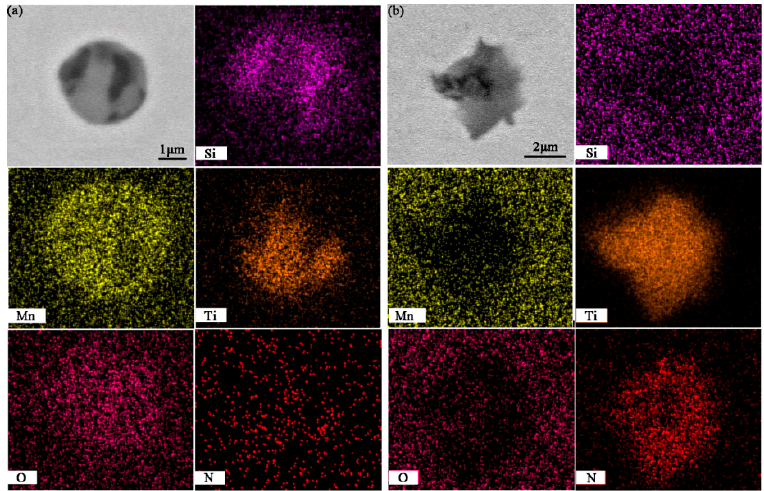
Figure 11. Elemental mapping of ( a ) a typical dual phase oxide formed in S1 condition; ( b ) a typical complex TiN formed in S2 (online version in color).